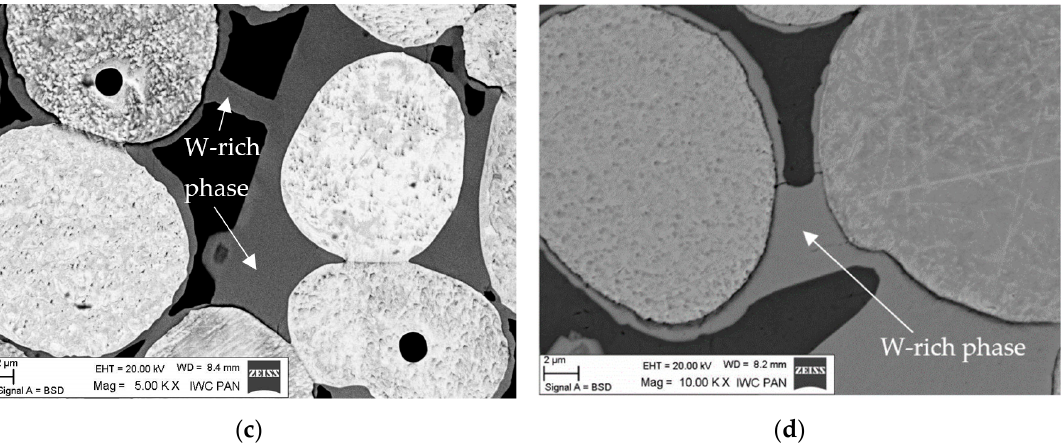
Figure 3. SEM images of the microstructure of the WNi5Co5 sample. Arrows and white circles indicate the position of the W-rich phase. Magnification: ( a ) 800×, ( b ) 3000×, ( c ) 5000×, ( d ) 10000×. It is worth noting that this phase occurred in the shape of needle-shaped precipitates and formed a shell on the tungsten grains (Figure 3d).